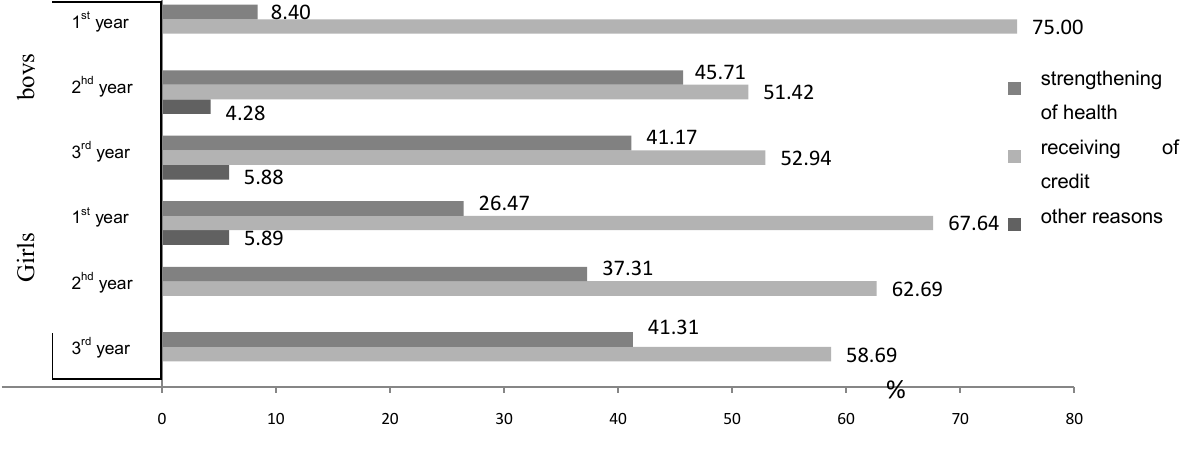
Fig. 7. Reasons of students’ attendance of physical culture classes in SRW